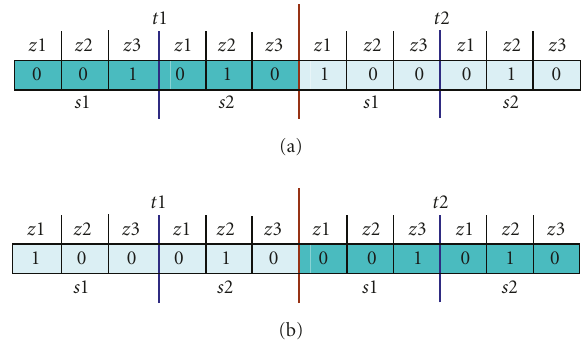
Figure 2: Time-exchange crossover operation (a) before crossover and (b) after crossover. t 1 and t 2 of chromosome are exchanged to generate a new chromosome.